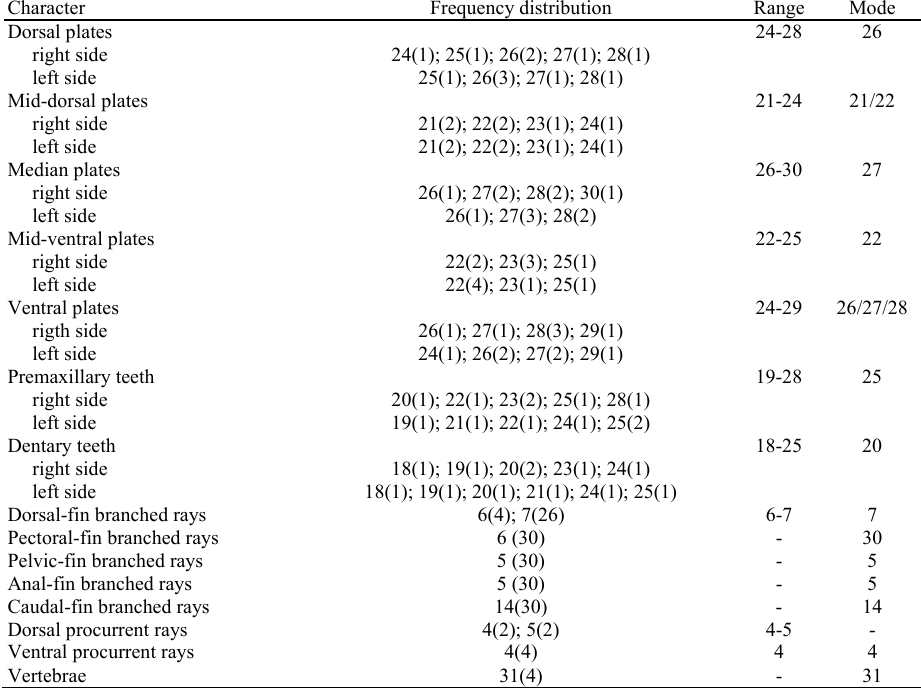
Table 2. Frequency distribution of meristics for Rhinolekos britskii (DZSJRP 5614, 6514, 6884, 7018, 7022, 7036, 7042, 12190; MCP 44058; MNRJ 34128; MZUSP